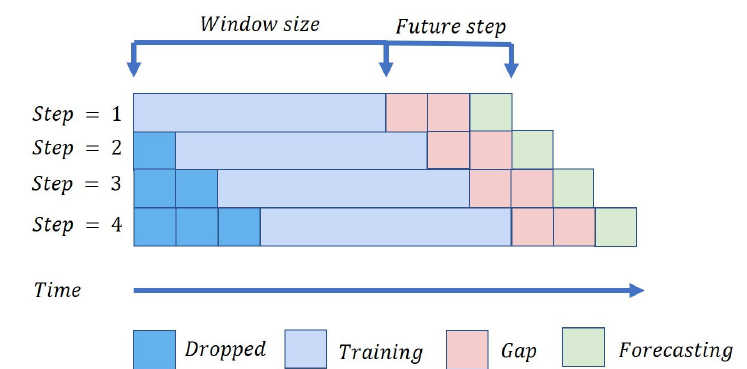
Figure 5. The schematic diagram of the sliding